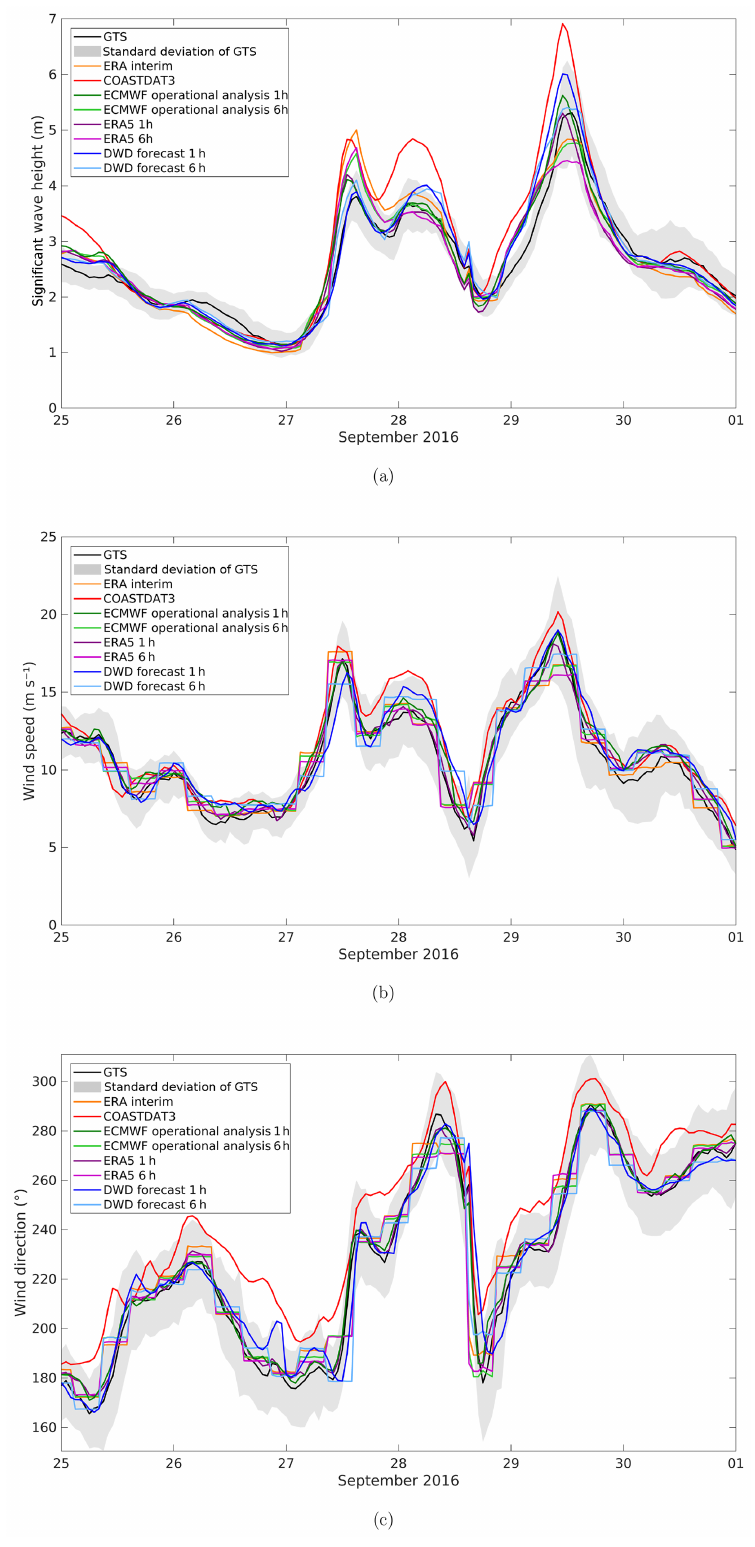
Figure 6. Time series of significant wave height (m) as modelled by WAM with different wind forcings and GTS measurements within the northern part of the North Sea (55 ◦ N, 2 ◦ W to 60 ◦ N, 5 ◦ E; white box in Fig.